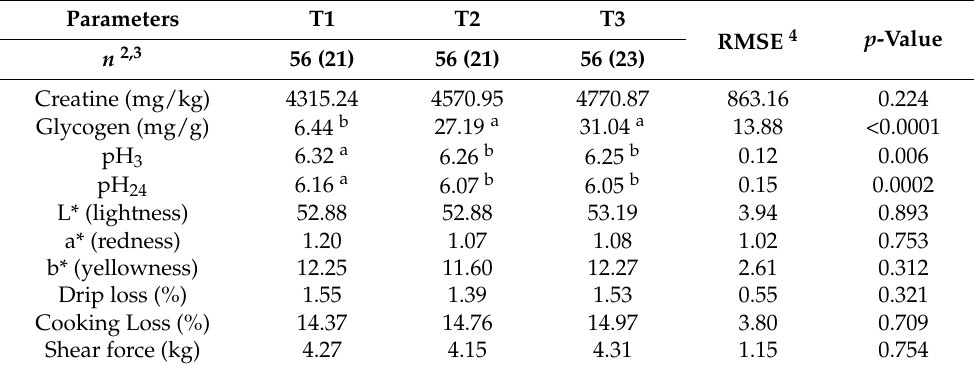
Table 6. Effect of guanidinoacetic acid (GAA) dietary supplementation 1 on creatine concentration, glycogen concentration and meat quality.